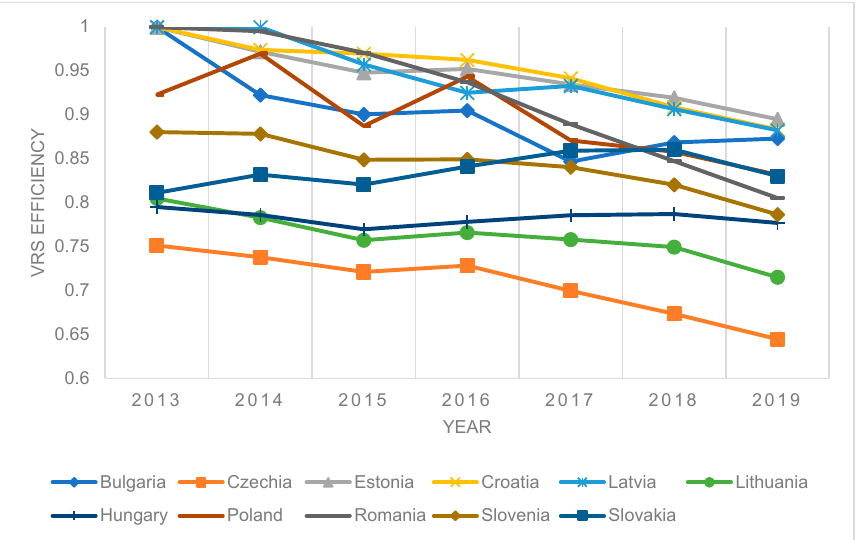
Figure 4. Results of DEA WINDOW efficiency measurement—VRS model, selected countries. Table 3 summarizes the country-specific DEA results of the CRS and VRS models. Above the line are the countries that joined the EU after 2004 inclusive . Table 3. Summary results of DEA Window efficiency measurement.